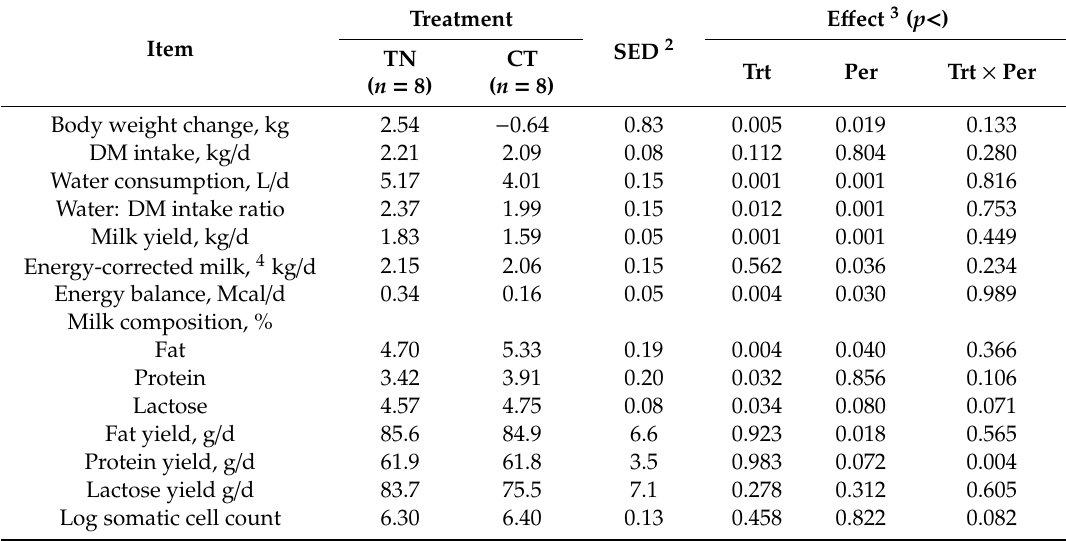
Table 3. Productive variables of dairy goats under thermoneutral (TN, 15 to 20 ◦ C) or cold temperature (CT, − 3 to 6 ◦ C) conditions 1